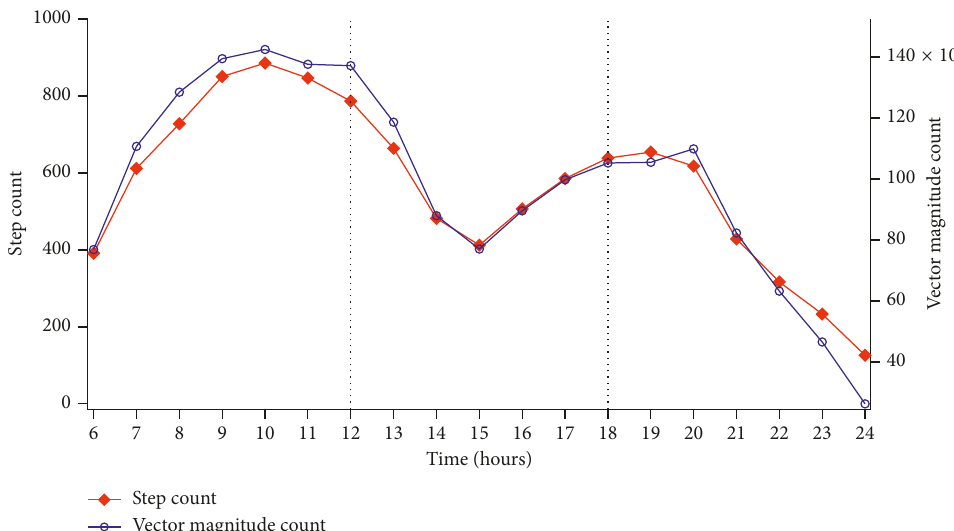
Figure 1: Hourly trend (average value of 3 months) of step counts and vector magnitude